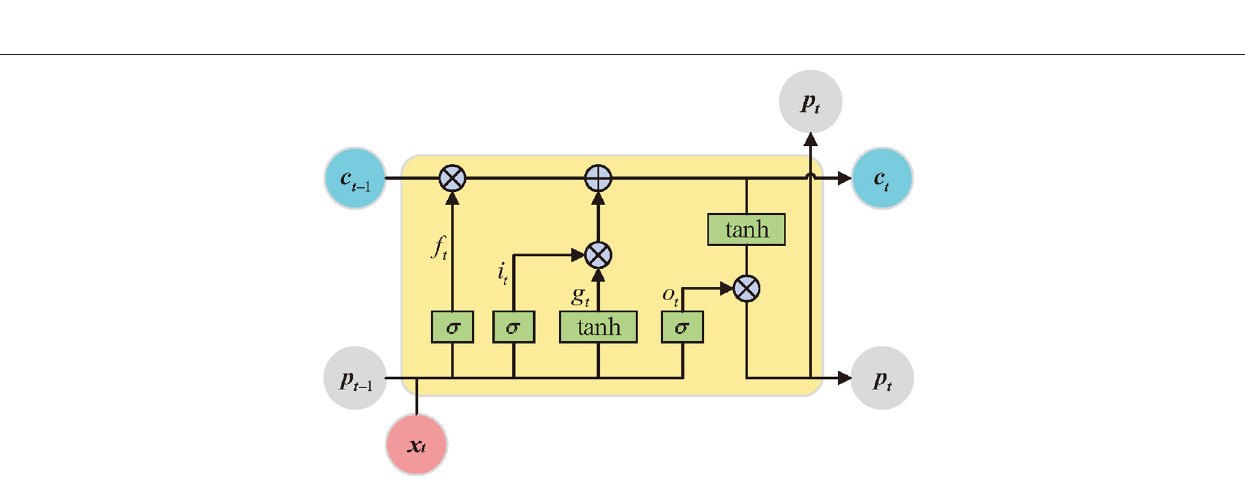
FIGURE 11 | Structure of